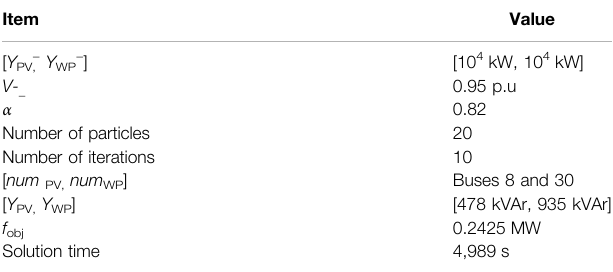
TABLE 3 | Optimum planning